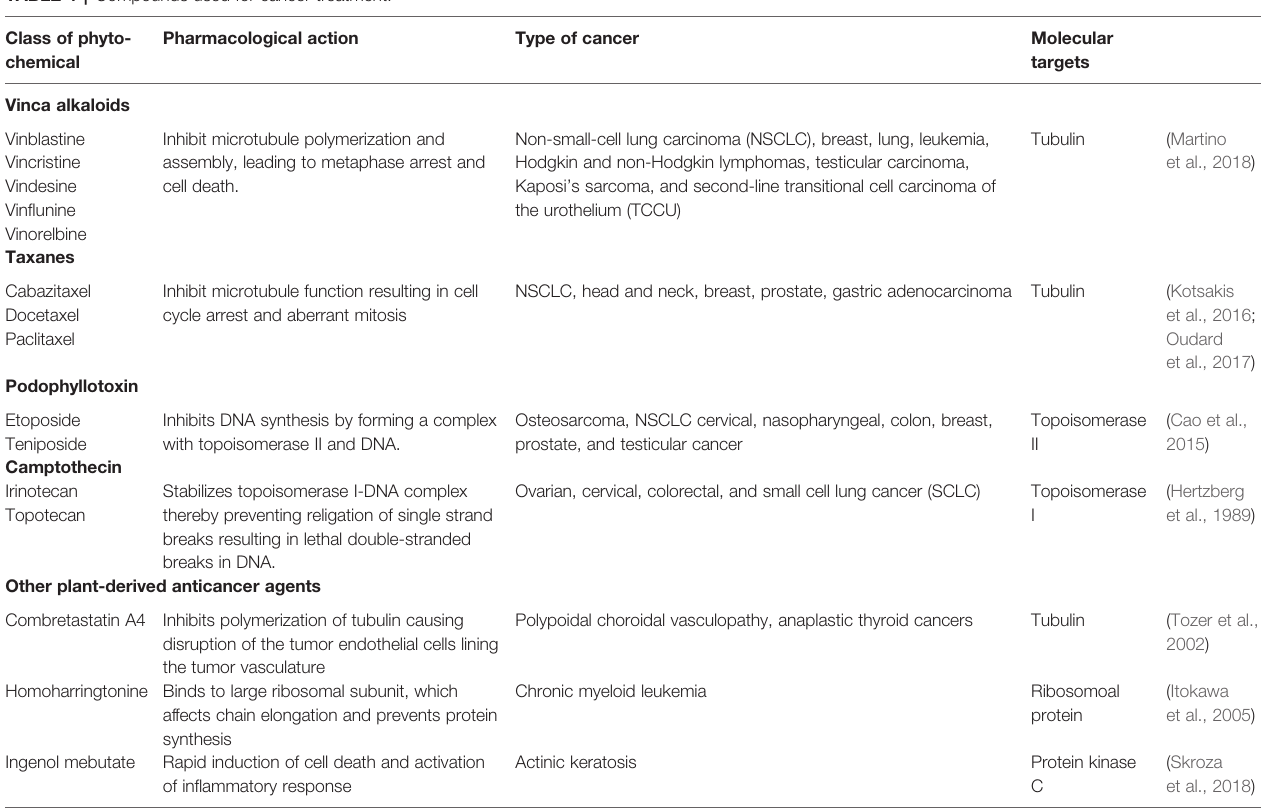
TABLE 4 | Compounds used for cancer